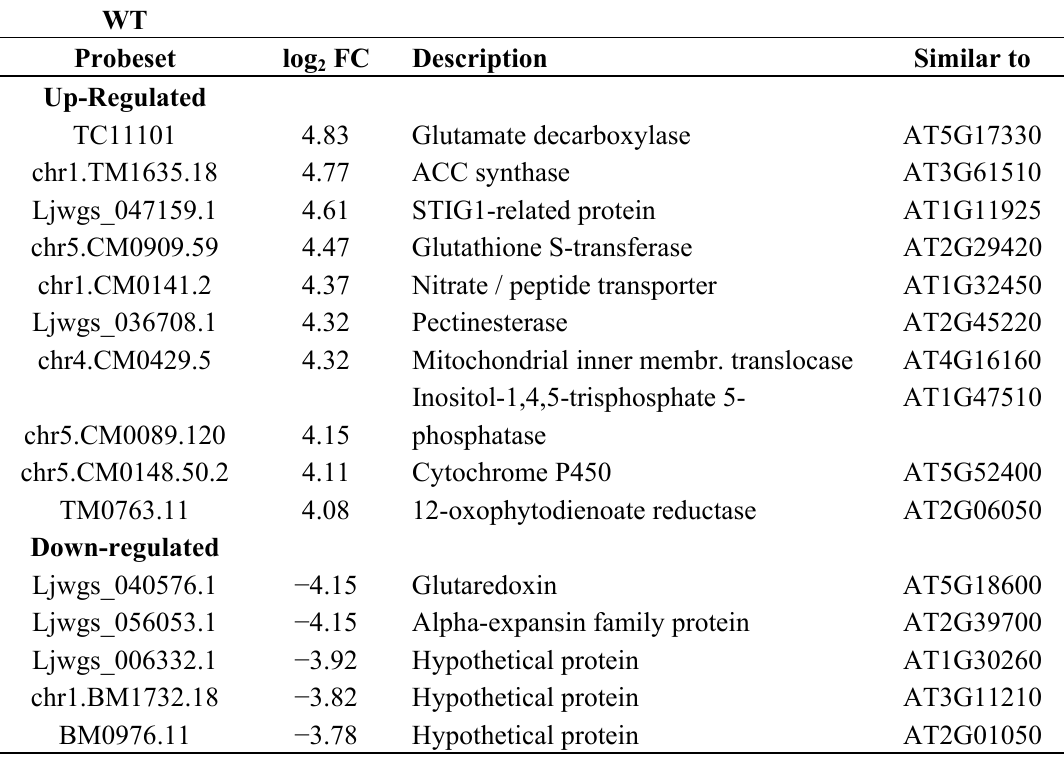
Table 5. Top 10 genes up- or down-regulated by drought in WT and Ljgln2-2